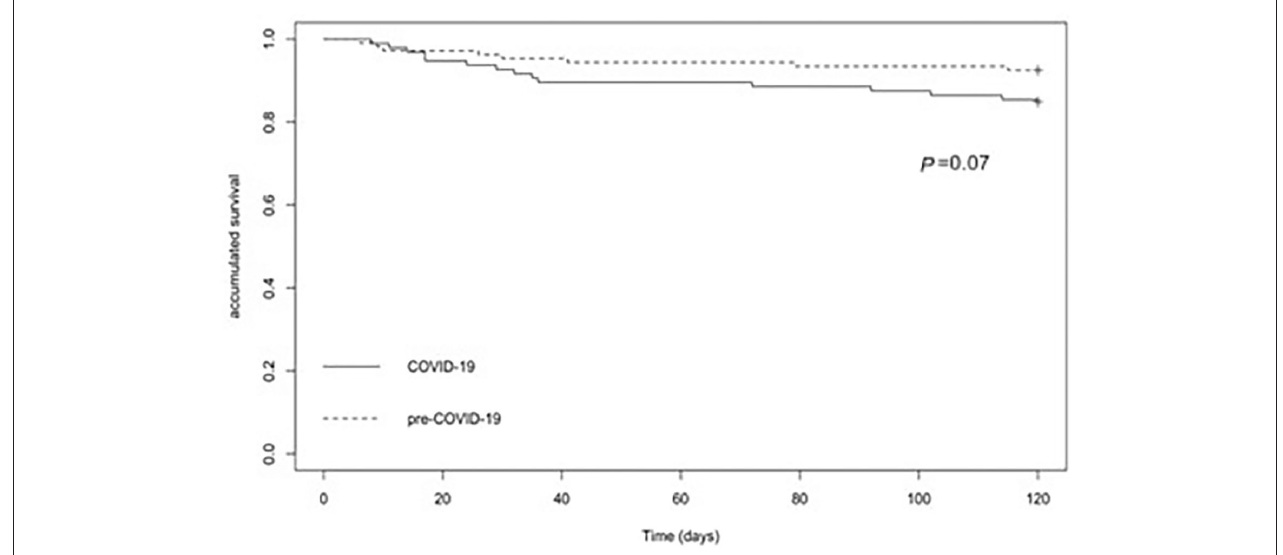
FIGURE 1 | The Kaplan–Meier plots among the patients with the intra-abdominal infections (IAI) during the pre-coronavirus disease 2019 (COVID-19) pandemic period and the COVID-19 pandemic period.